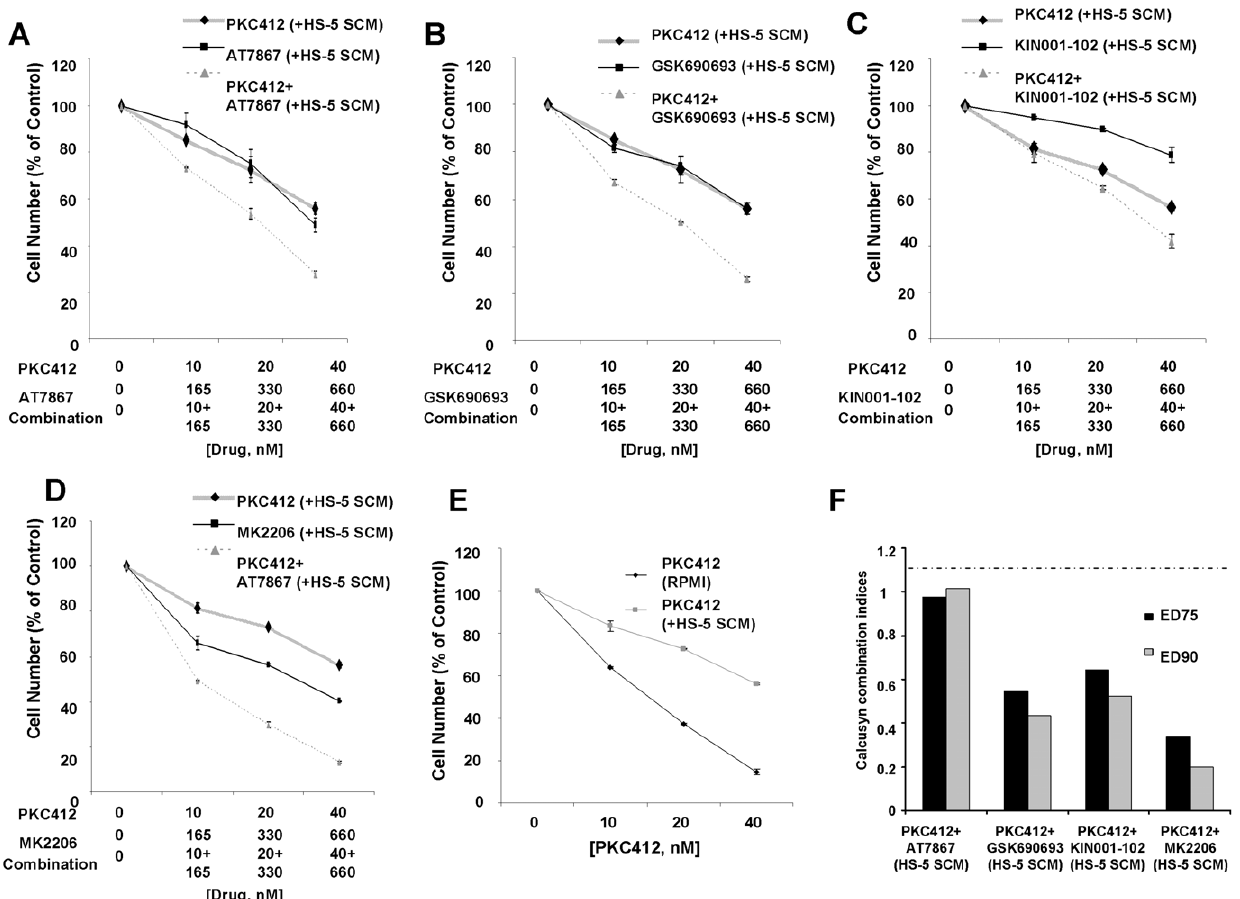
Figure 2. Selective inhibitors of AKT positively combine with PKC412 in the presence of SCM against MOLM14-luc + cells. (A–D) Approximately two-day proliferation studies performed with selective AKT inhibitors in combination with PKC412 in the presence of HS-5 SCM. (E) Approximately two-day PKC412 treatment of MOLM14-luc + cells cultured in the absence or presence of HS-5 SCM (n=2). (F) Calcusyn combination indices derived from the 4-point concentration proliferation experiments shown in A-D. The cut-off for nearly additive effects (C.I.: 1.1) is marked by a dashed line.